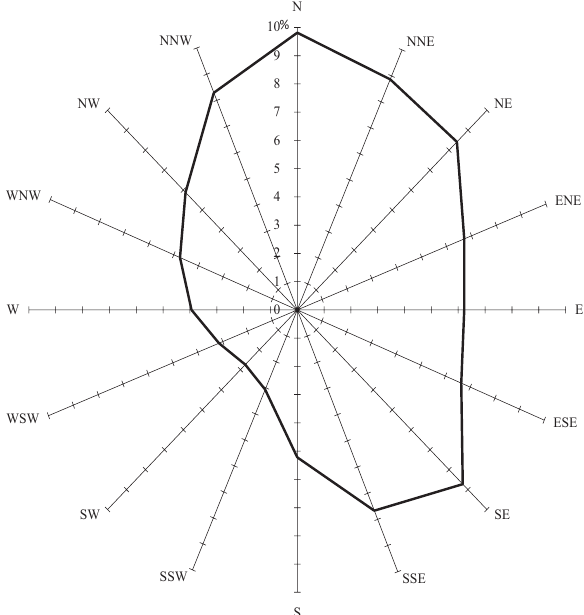
Figure 4. Wind distributions (%) during the first study period (From January to August,